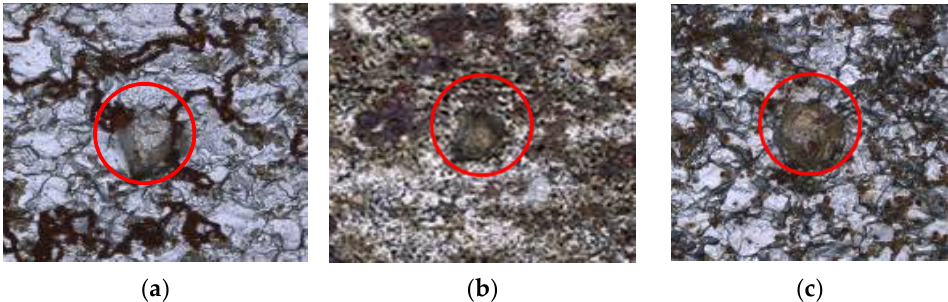
= 0.01 MPa; ( b ) P CO 2